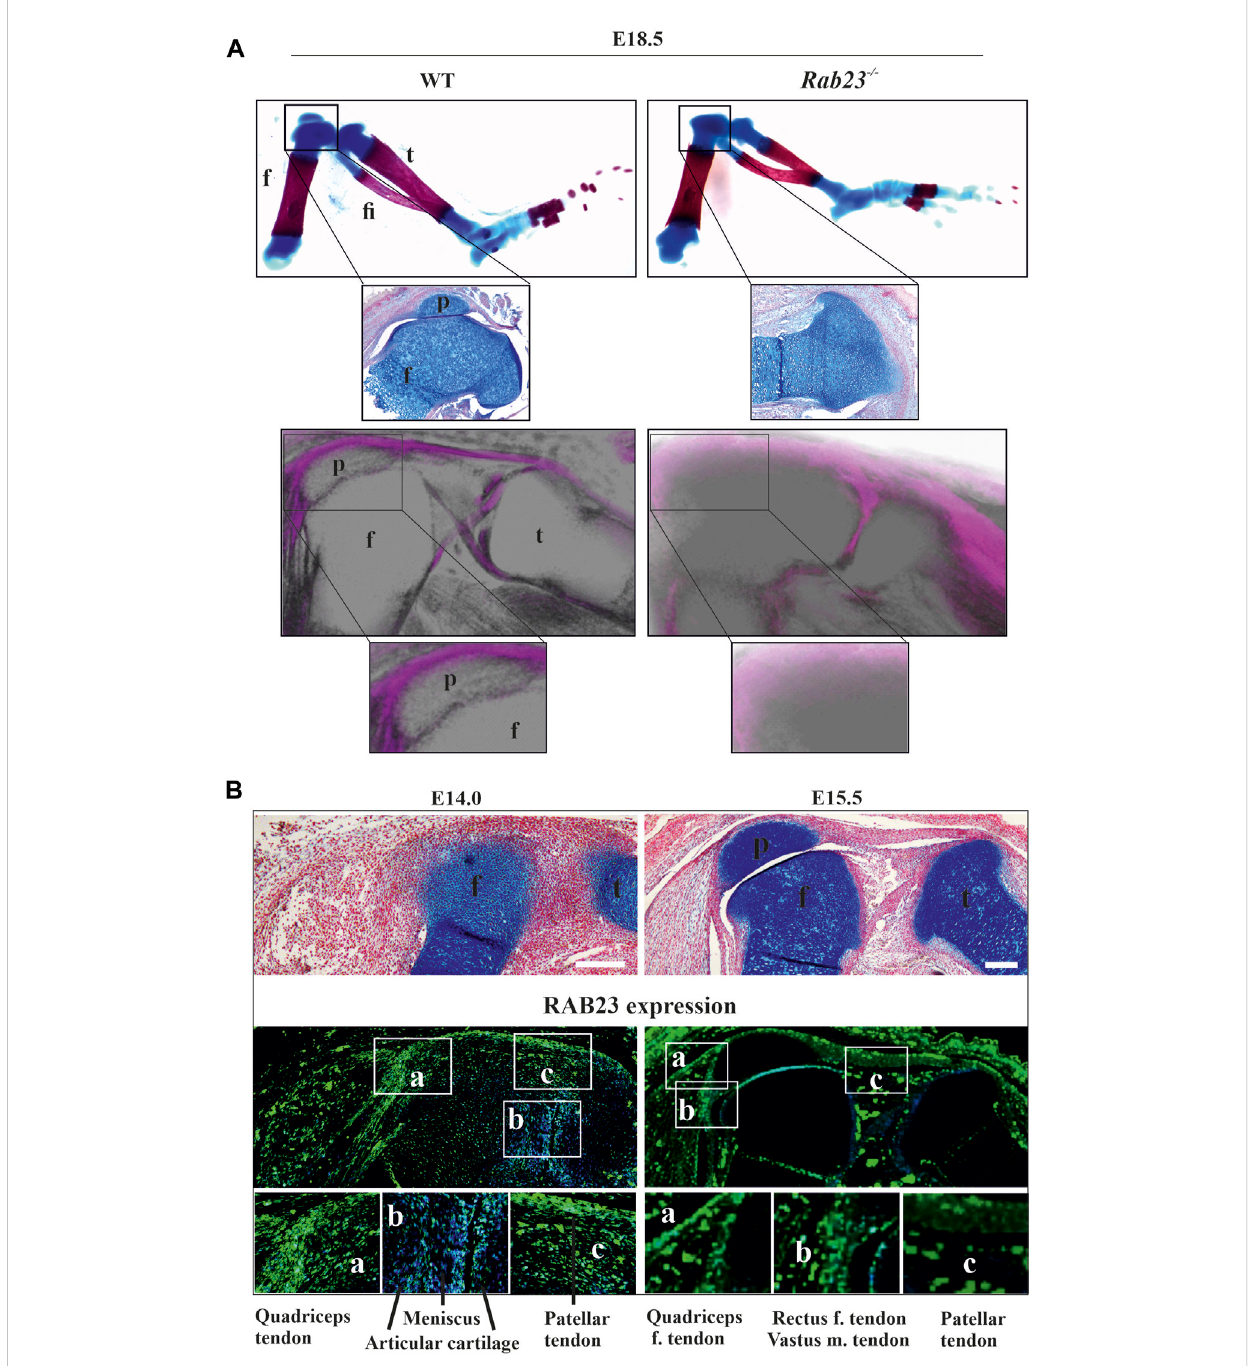
FIGURE 1 Rab23 − / − micefailedtodeveloppatellaand analysis ofRAB23proteinexpressioninthedeveloping patella. (A) AnalysisofpatellaformationinWtand Rab23 − / − miceatE18.5byAlcianblueandAlizarinredstaining(upperpanel)andbyµ-CTimaging(lowerpanel).BothanalysismethodsshowthatwhileWt mice developed patella, Rab23 − / − mice failed to form patella. The absence of patella development in Rab23 − / − mice was further con fi rmed by Alcian blue and fast red staining ofthesagittal-sectional tissue fromthe hind limbs (inset, upper panel) atE18.5. ( n = 10 samples for each genotype). p: patella, f: femur, t: tibia, and fi : fi bula. (B) Immunohistochemical expression analysis of RAB23 in the Wt sagittal-sectional tissues of the hind limbs obtained from E14.0 and E15.5 embryos (lower panel). Expression analysis shows that RAB23 is expressed in the developing patella, patella tendon, quadriceps tendon, rectus femoris tendon, and vastus medialis tendon. RAB23 expression is also observed in the meniscus and articular cartilage. To highlight the cartilage cellsofthepatella,sagittalsectionsfromE14.0andE15.5hindlimbsarestainedwithAlcianblueandfastred(upperpanel).( n =3samplesforeachage).p: patella, f: femur, and t: tibia. Scale bar: 200 μ